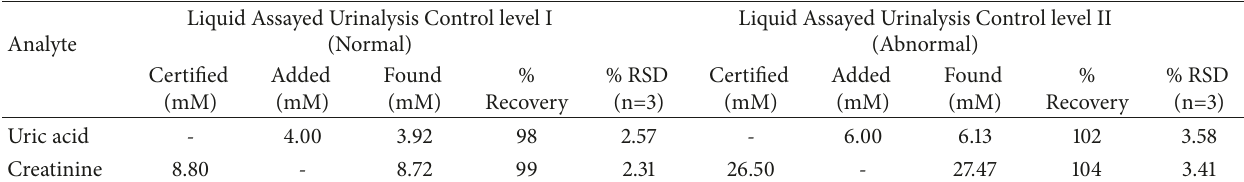
Table 2: Determination of uric acid and creatinine in the control urine